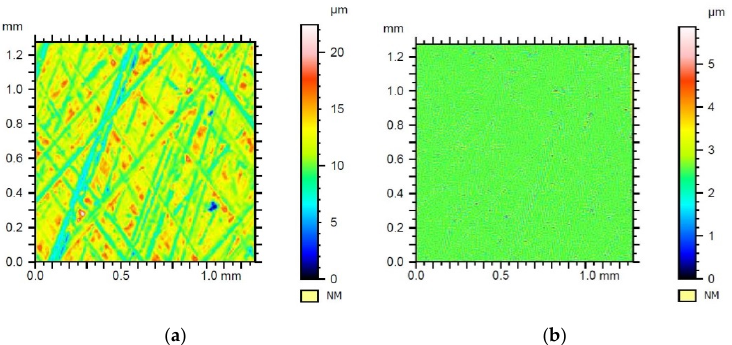
Figure 8. Results of filtration of the surface geometrical structure of sample 1 with Daubechies wavelet of the 3rd row with the 1st level of filtration—( a ) waviness, ( b ) roughness.